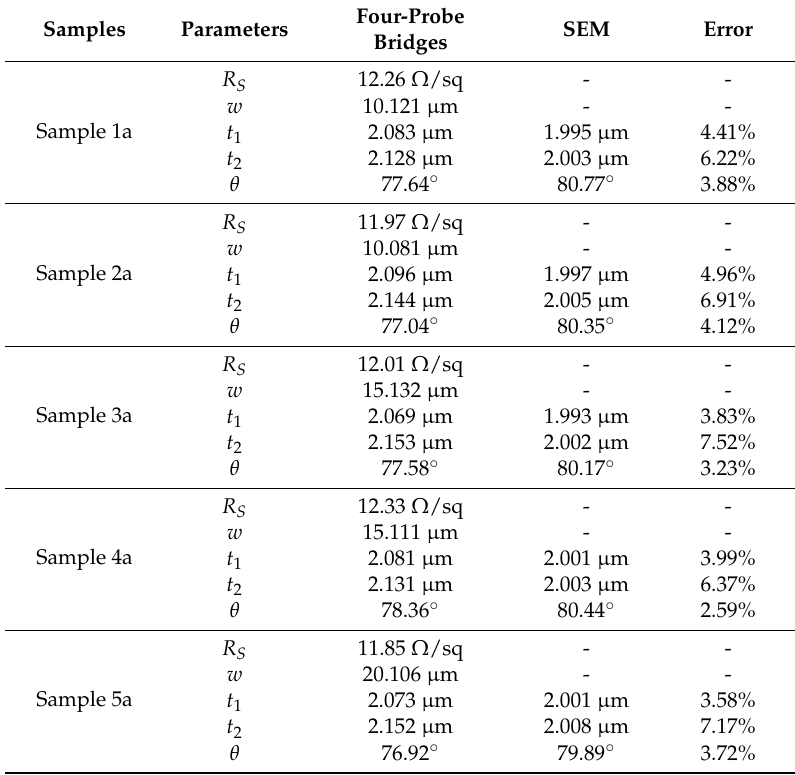
Table 1. Experimental results of Poly 1 layer and Oxide 1 layer.